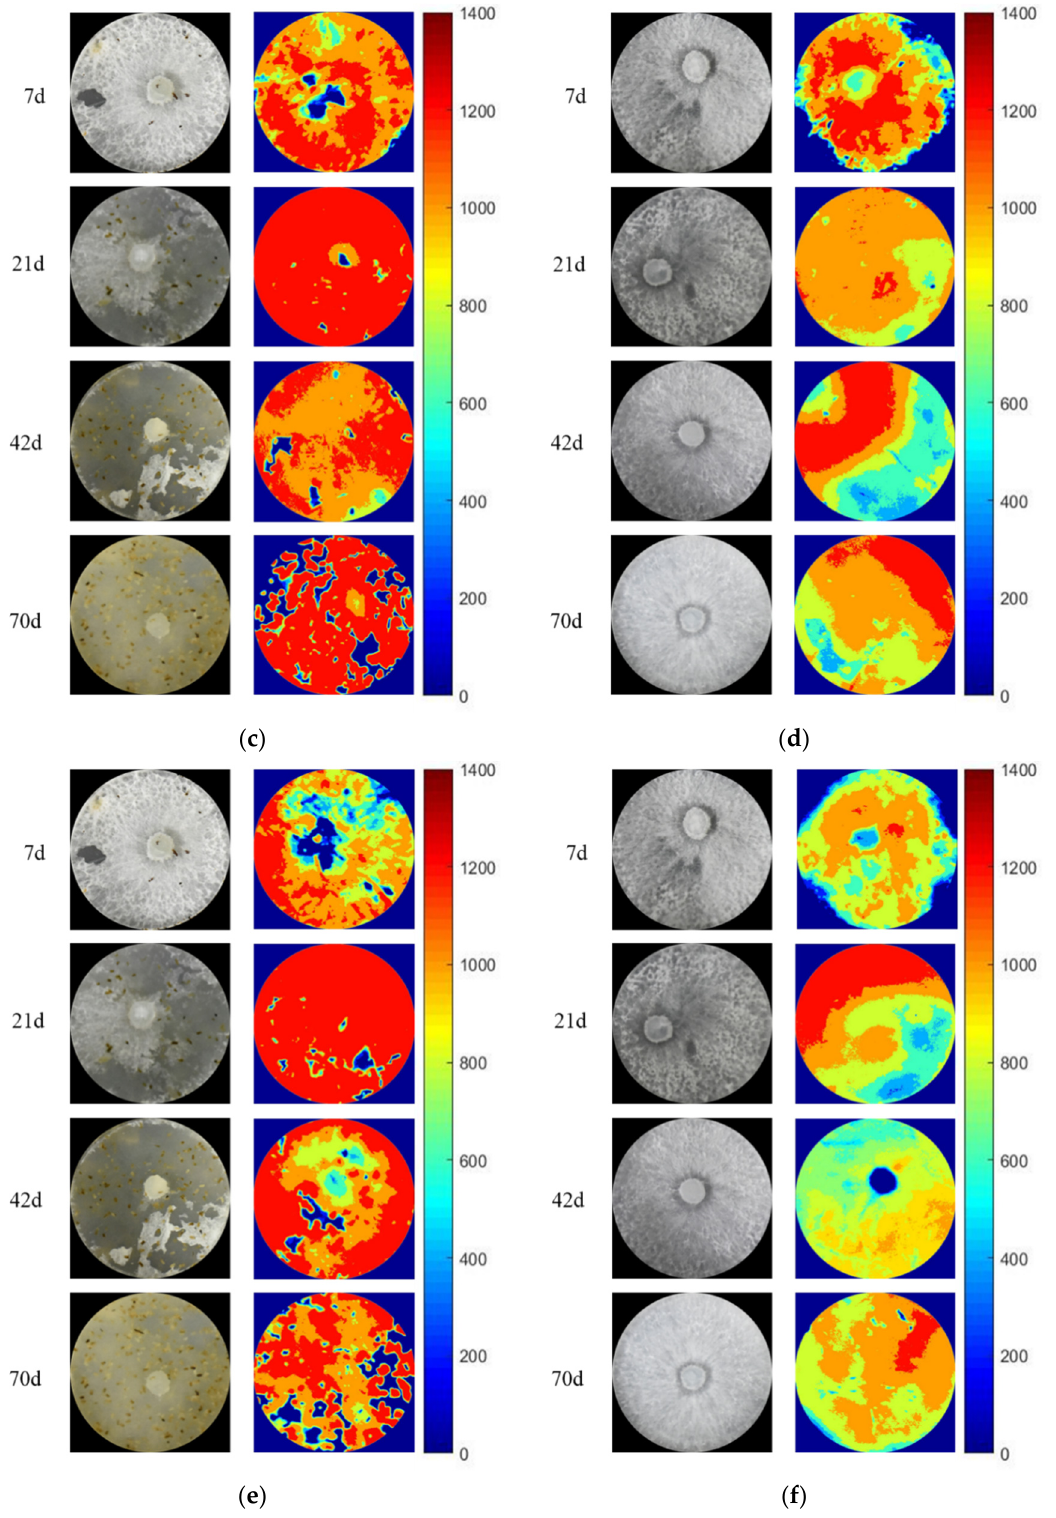
Figure 4. Spatial distribution of enzyme activities of grazing areas (External litter: Q. variabilis ): ( a , b ) acid phosphatase, ( c , d ) β - N -acetylhexosaminidase, ( e , f ) β -1,4-glucosidase. ( a , c , e ) under isopods grazing; ( b , d , f ) without isopods grazing. The side color map is proportional to the enzyme activities (pmol·cm − 2 ·h − 1 ).